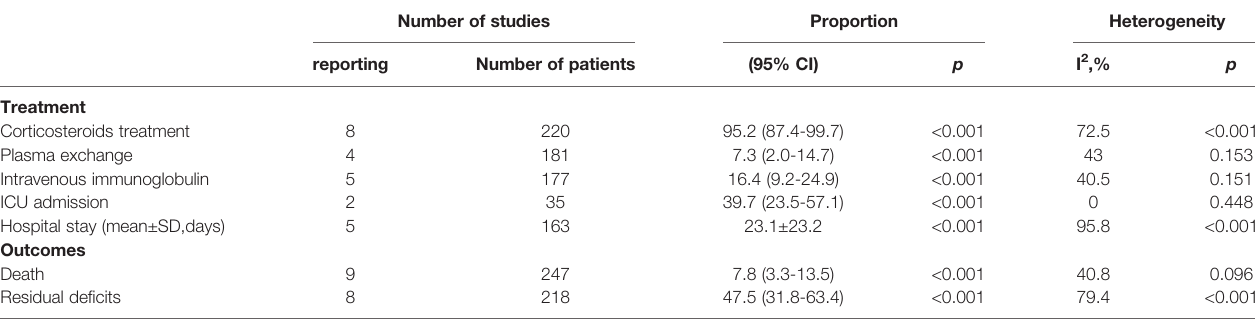
TABLE 4 | Treatment and outcomes of patients with